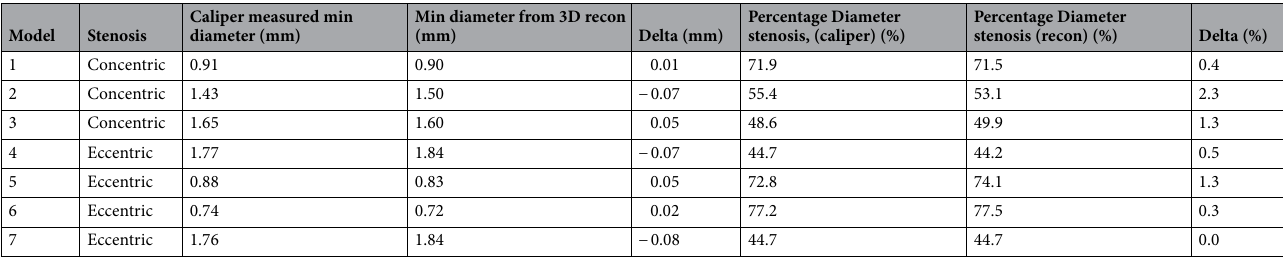
Table 1. Accuracy of diameter measurement the 3D CA method. The absolute (mm) and percentage error are reported for each of the seven stenosis models. Percentage stenosis was calculated as the ratio between reference (unstenosed) vessel diameter to diameter at the point of maximum